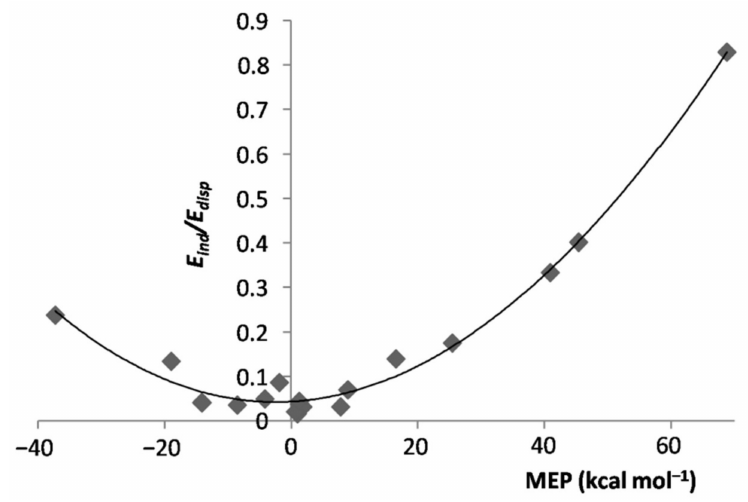
Figure 5. E ind / E disp ratio of the LArvs. MEP at the V S,max /V S,min of L.